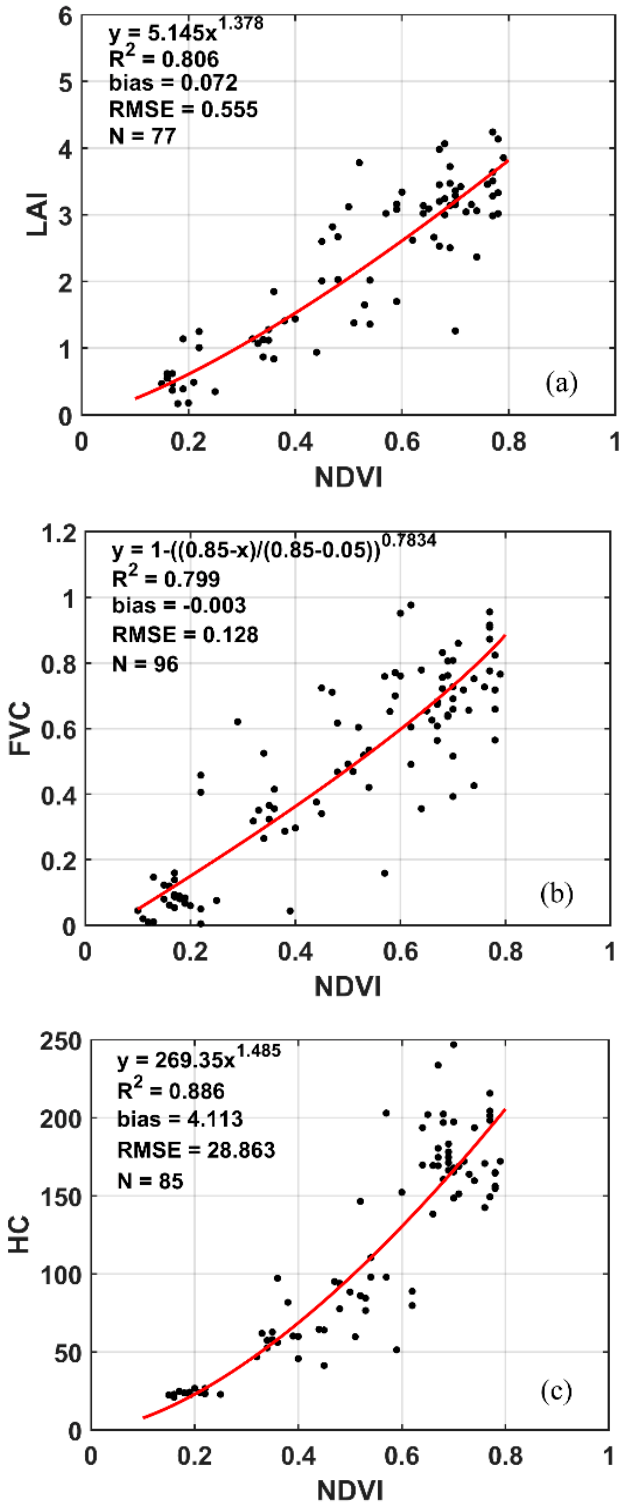
Figure 2. The established empirical relationship between ASTER NDVI and ( a ) leaf area index (LAI), ( b ) fractional canopy cover ( f c ) and ( c ) plant canopy height ( h c ) at 90m spatial resolution.